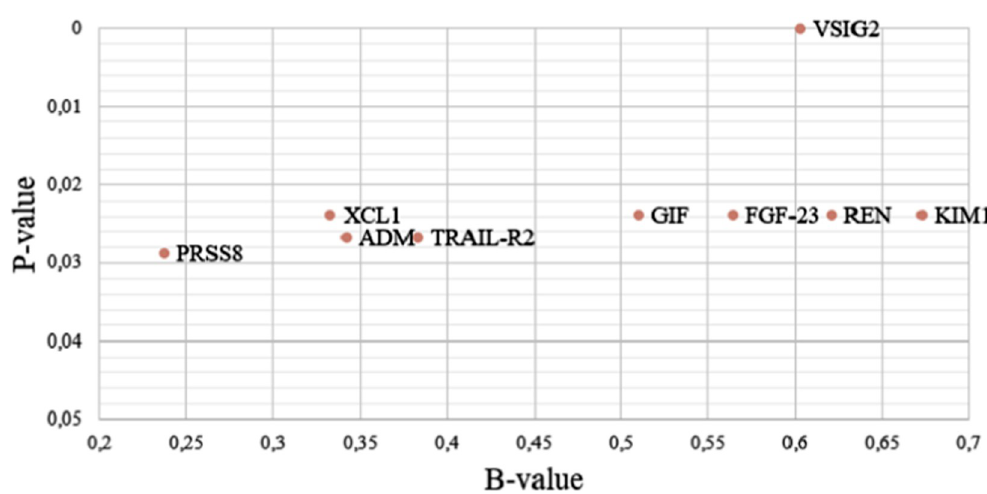
Fig 3. B-value vs P-value in 9 proteins significantly altered in subjects with combined diagnosis compared with no combined diagnosis. Legend: See Table 3 legend for protein definitions.